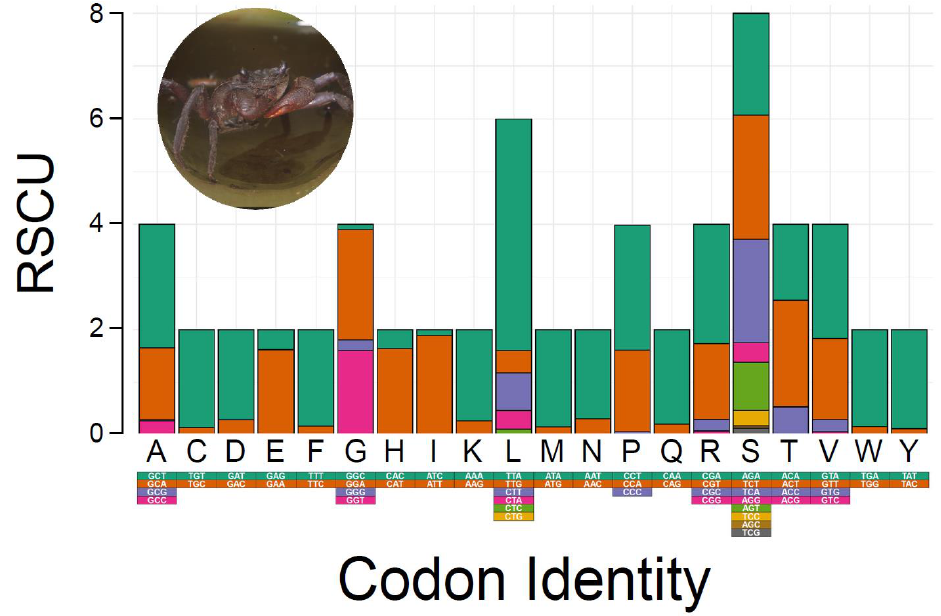
Figure 2. Relative synonymous codon usage (RSCU) in Metopaulias depressus. Photo credit: Rudolph Diesel.